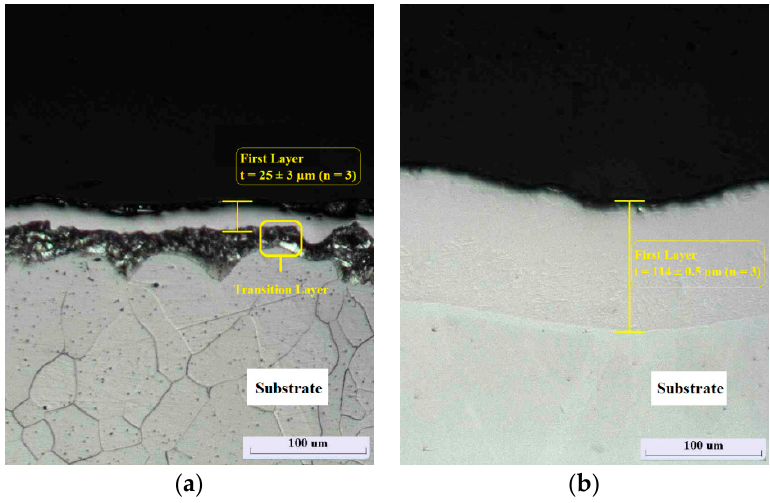
Figure 2. Microstructure image of chromized ( a ) low carbon steel, and ( b ) 316 stainless steel.